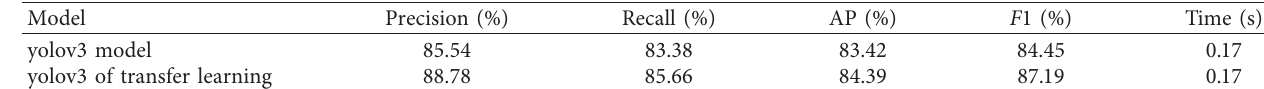
Table 2: Comparison of test results of two